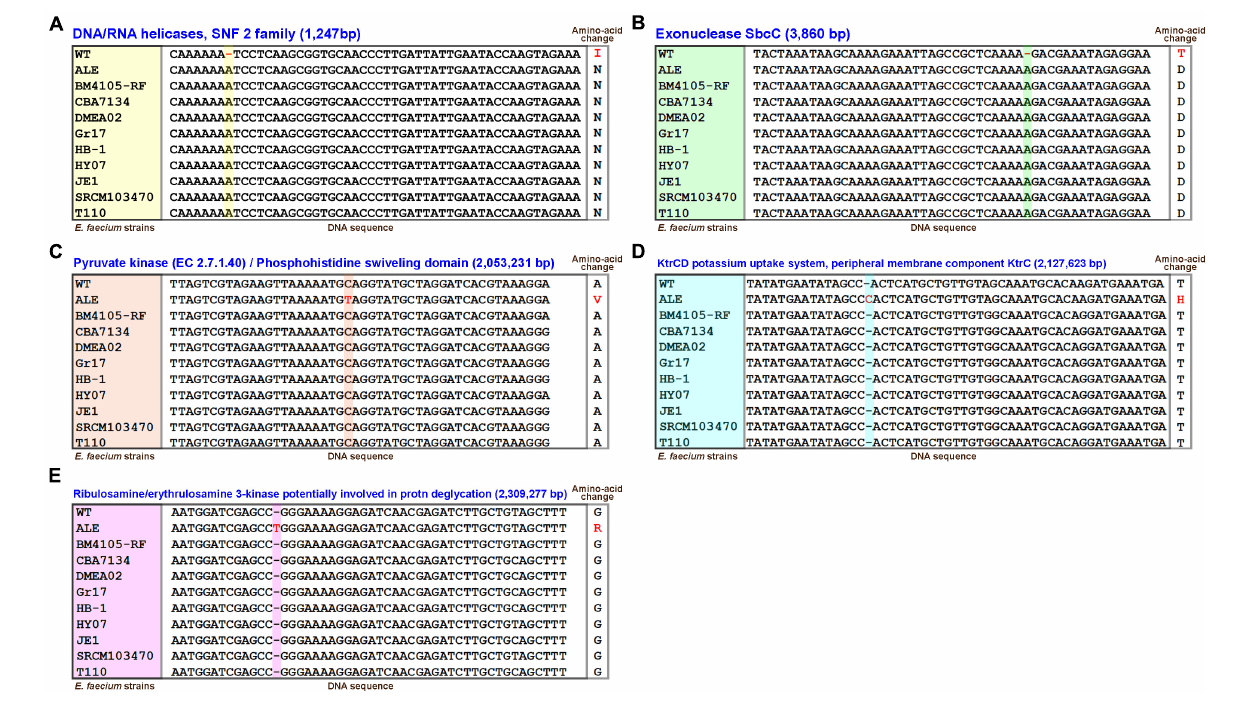
FIGURE 6 | The 5 variants called by comparing BIOPOP-3 WT and ALE strains. (A) DNA/RNA helicase, (B) exonuclease SbcC, (C) pyruvate kinase/Phosphohistidine swiveling domain, (D) KtrCD potassium uptake system, peripheral membrane component KtrC, and (E) ribulosamine/erythrulosamine 3-kinase. The genotypes of nine E. faecium strains that were evolutionarily close to BIOPOP-3 were also